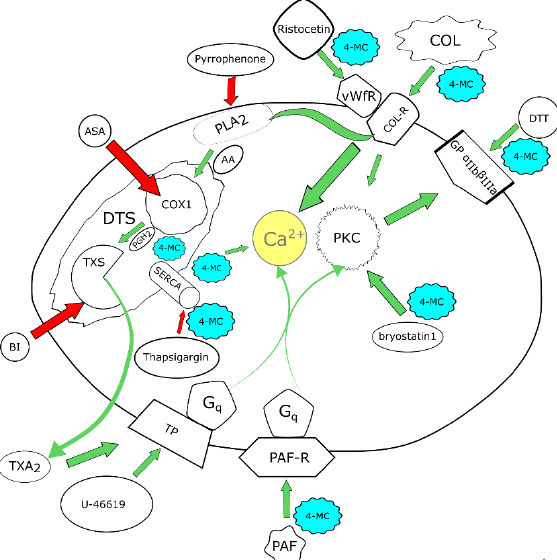
Figure 7. Summary of the tested effects of 4-methylcatechol (4-MC) in the platelet. The red arrows show inhibition, while the green arrows show activation. Blue cloudlets with 4-MC show the places where 4-MC was active, e.g., where platelet aggregation triggered by the used inducer was affected by 4-MC. ASA—acetylsalicylic acid, COX1—cyclooxygenase 1, AA—arachidonic acid, PLA 2 —phos-